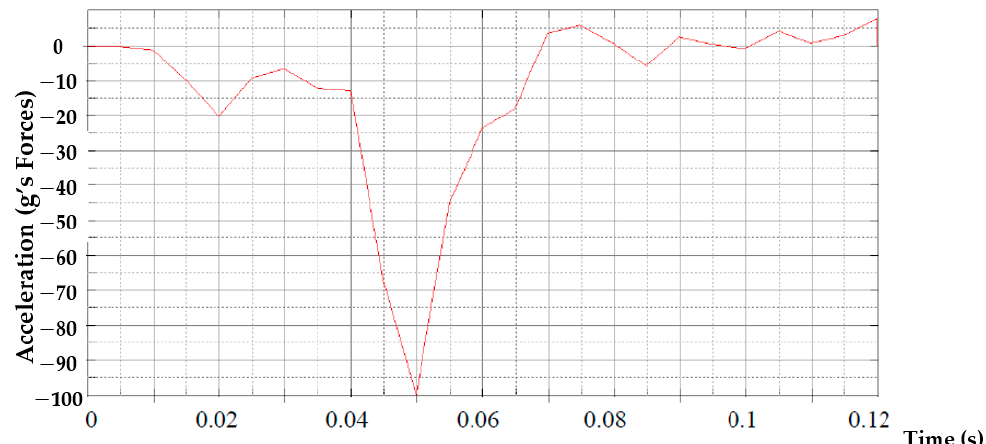
Figure 5. Armored SUV driver’s seat acceleration on the X-axis.